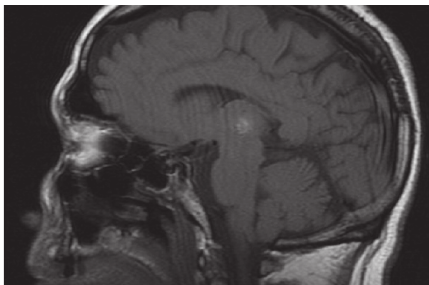
Figure 3: Magnetic resonance imaging where we can observe hemorrhagic transformation in the left thalamus of the